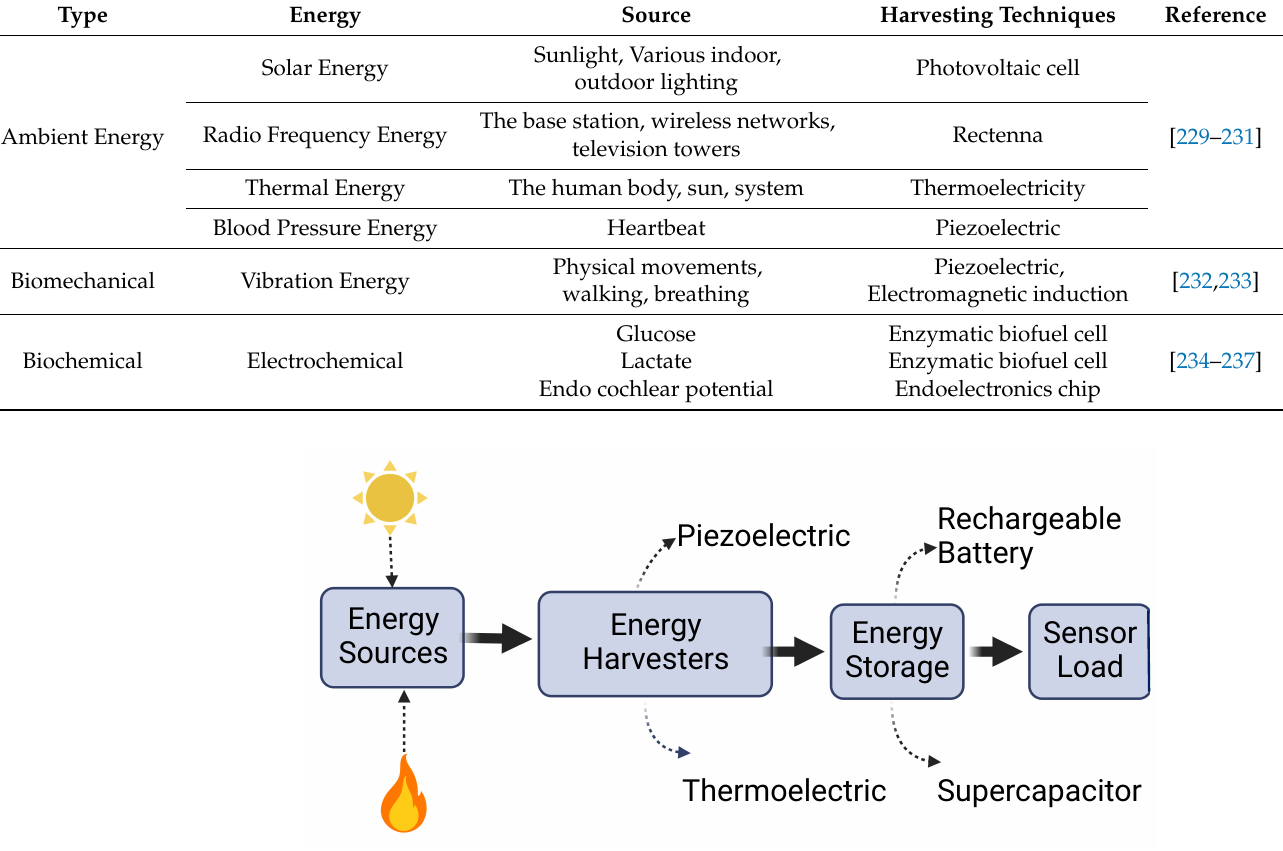
Figure 17. The harvesting process for a sensor node in wireless body area networks. Energy from nonelectrical sources is scavenged and converted to electric potential using appropriate energy harvesters for specific source.